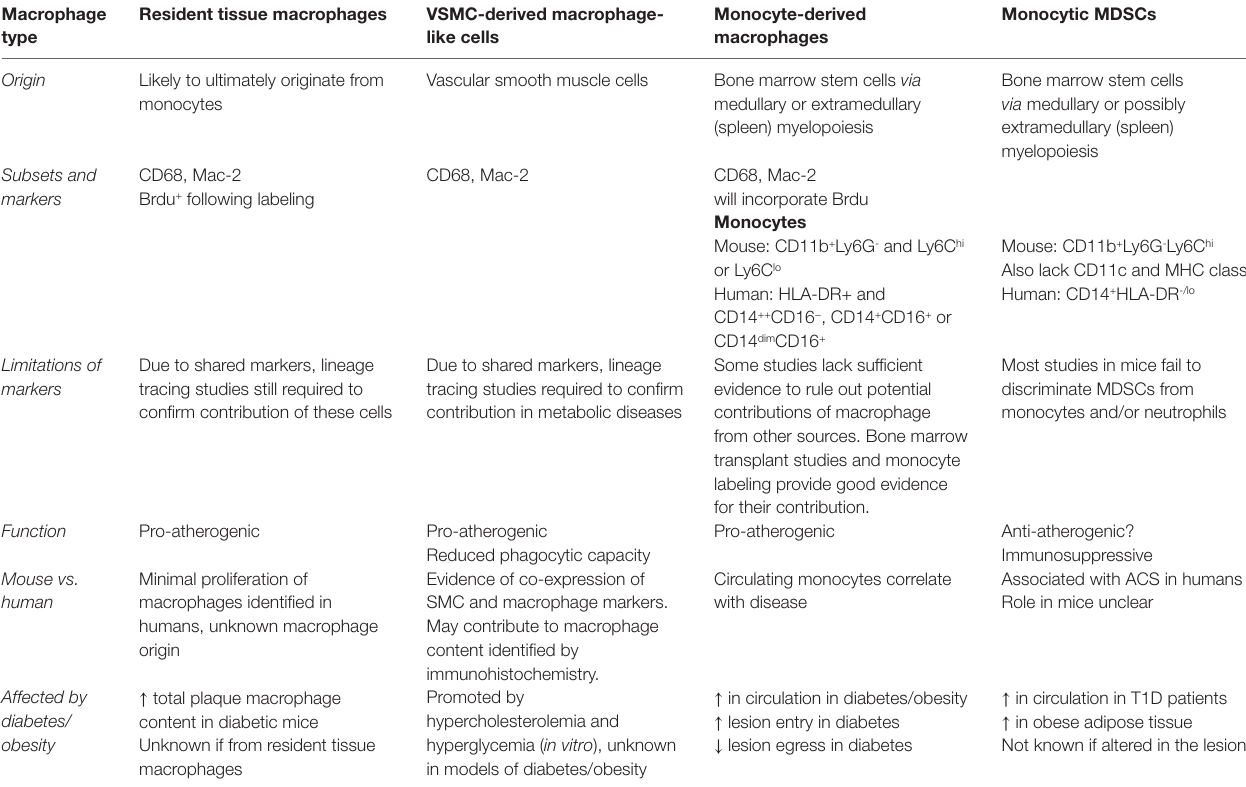
TABLE 1 | Summary of the sources of macrophages and macrophage-like cells within the plaque and their role in atherosclerosis and metabolic